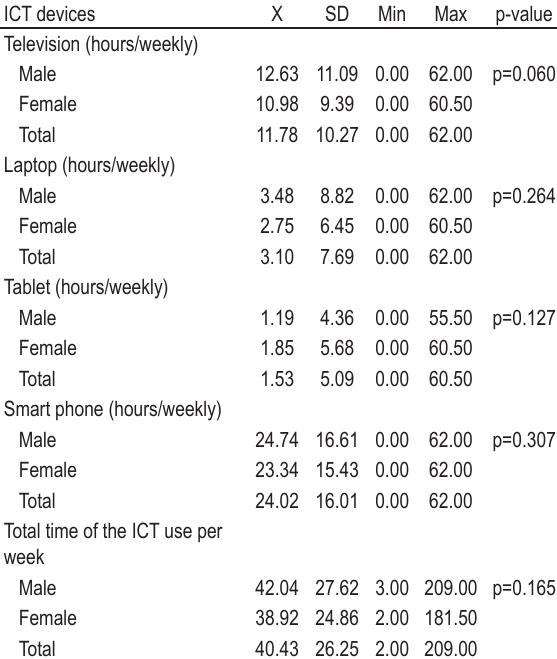
TABLE 1. Average time of using the ICT devices per gender TABLE 2. Average intensity of pain in different segments of body per